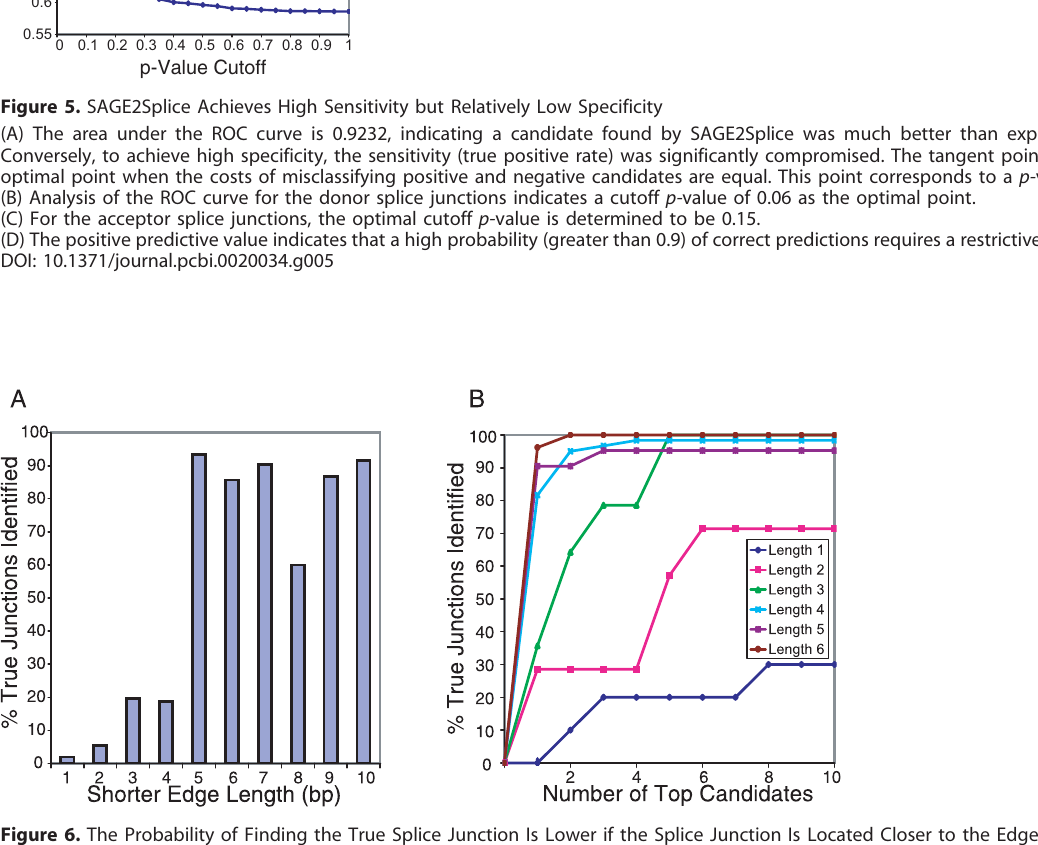
Figure 6. The Probability of Finding the True Splice Junction Is Lower if the Splice Junction Is Located Closer to the Edge of a Tag By using the unmapped tags in the Mouse Atlas Project that map to spliced tags predicted from EST transcripts, the percentage of true splice junctions found was analyzed for each short edge length. (A) By using high specificity parameters (cutoffs of 0.06, 0.15, and 0.25 for donor, acceptor, and composite p- values, respectively), 93% of the true splice junctions were found when the shorter edge is greater than or equal to 5 bp in length. (B) With no p- value cutoffs, 90% of the true splice junctions were found with the top-ranked p- value when the shorter edge is 5 bp in length. DOI: 10.1371/journal.pcbi.0020034.g006 PLoS Computational Biology |